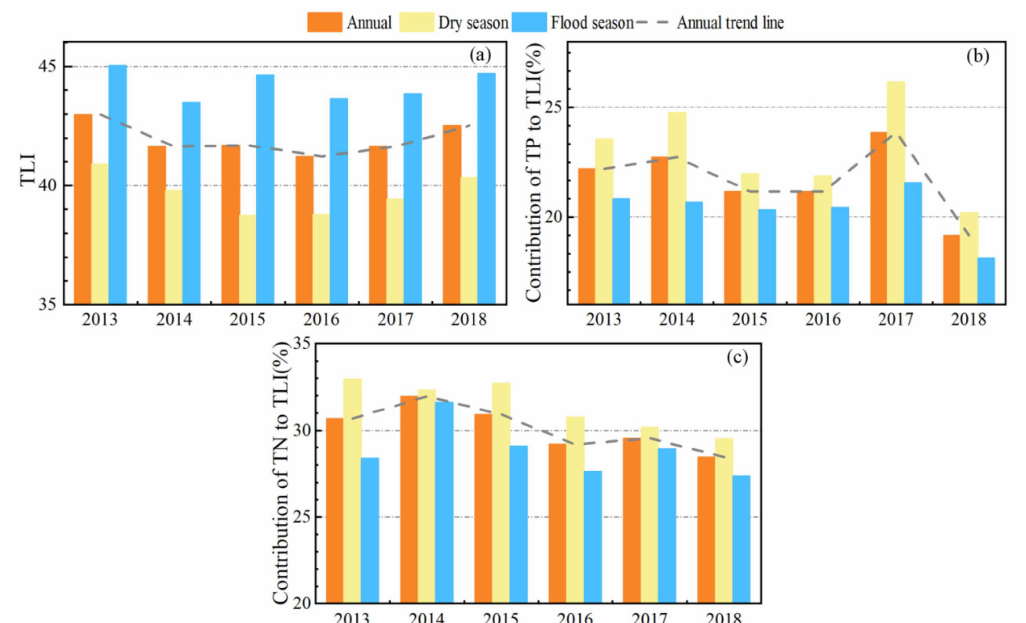
Figure 3. Contribution rates of annual TLI and total phosphorus (TP) and total nitrogen (TN) to trophic level index (TLI): ( a ) variation trend of annual and seasonal TLI; annual and seasonal contribution rates of ( b ) TP to TLI and ( c ) TN to